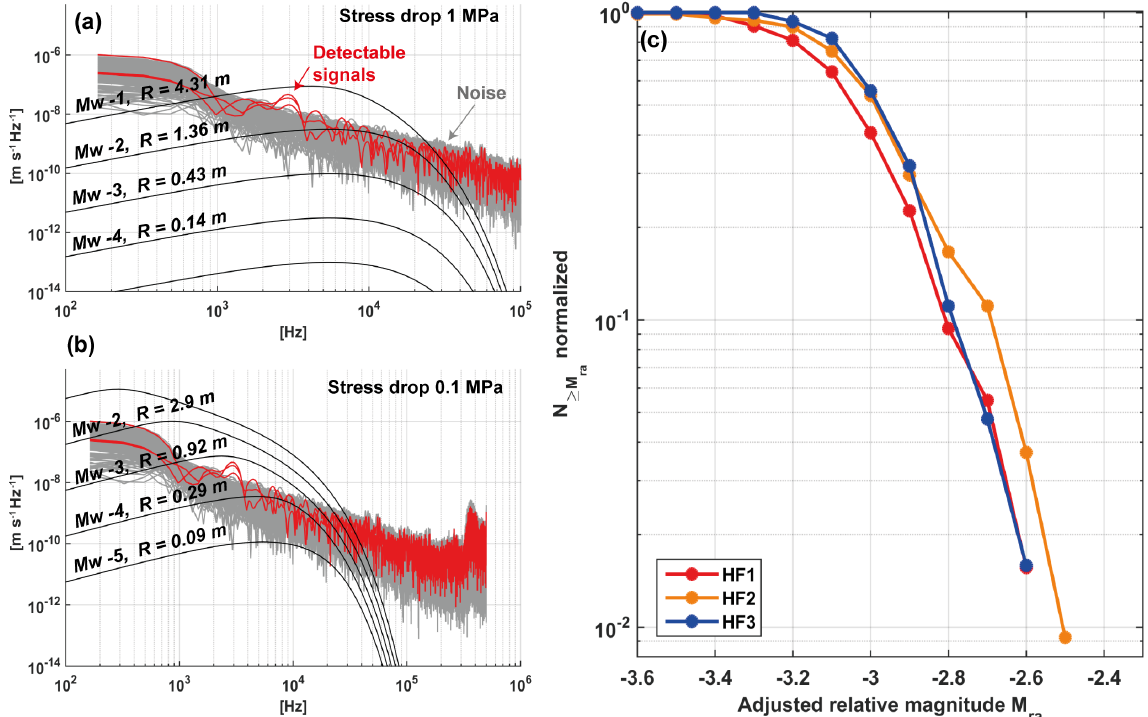
Figure 10. ( a and b ) Noise spectra of the accelerometer at sensor position S8 (grey) and the spectra of three events detected at the accelerom- eter (red) slightly emerging above the noise. Superimposed are theoretical spectra for different magnitudes ( M w − 4 . 0 to − 1 . 0). R denotes the corresponding source radii. The stress drop in (a) was chosen to be 1MPa, and in (b) it was 0.1MPa. The detected signals (red) fall in the band between M w − 2.0 and − 1.0 for a stress drop of 1MPa and between M w − 4 . 0 and − 3 . 0 for a stress drop of 0.1MPa. (c) Frequency magnitude distribution of relative adjusted magnitudes M ra . These were adjusted so that the maximum magnitude is around M ra − 2 . 5, matching a middle value between the approximate maximum magnitude estimates from (a) and (b)